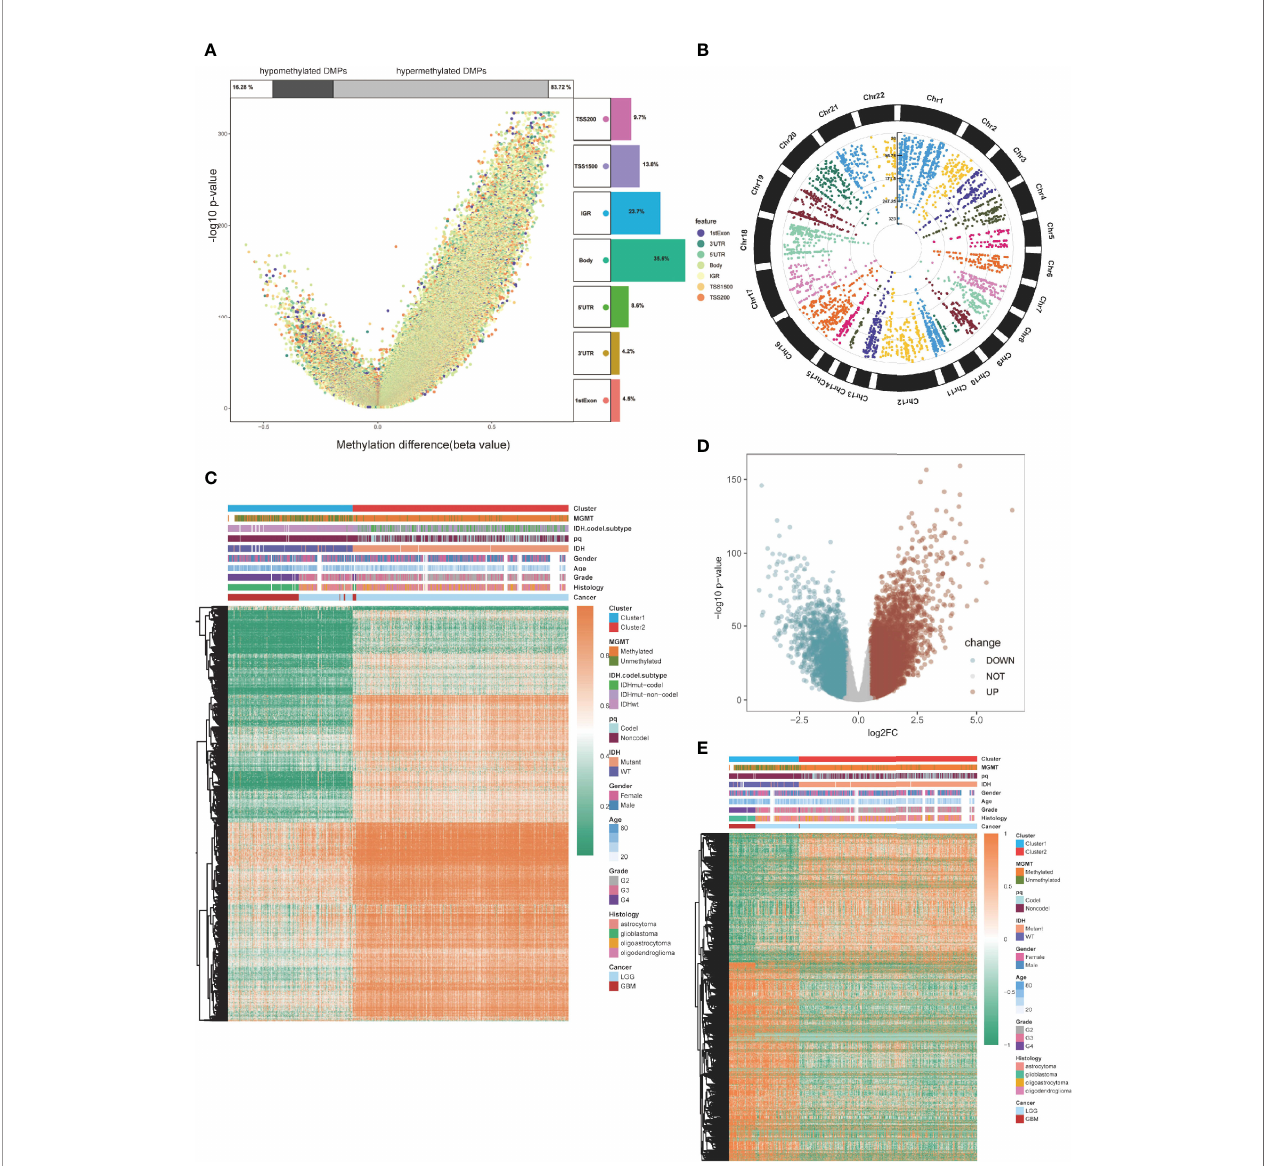
FIGURE 3 | Global DMPs and DEGs of the two clusters. (A) Volcano plot. Proportions of hypermethylated and hypomethylated DMPs are shown on top. The distribution of DMPs ’ feature is shown on the right. (B) The manhattan plot of the DMPs. (C) Heatmap of the two clusters based on the TCGA methylation set. High methylation, orange; low methylation, green. (D) Volcano plot of the DEGs. (E) Heatmap of the twp clusters based on the TCGA RNA-seq cohort. High expression, red; low expression,